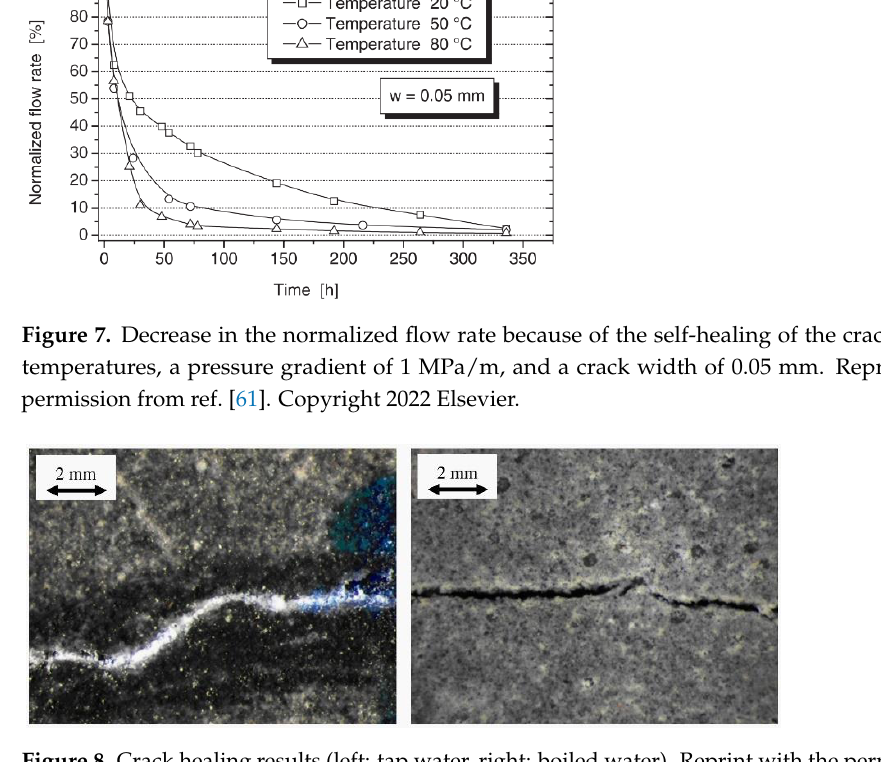
Figure 8. Crack healing results (left: tap water, right: boiled water). Reprint with the permission from ref. [36]. Copyright 2022